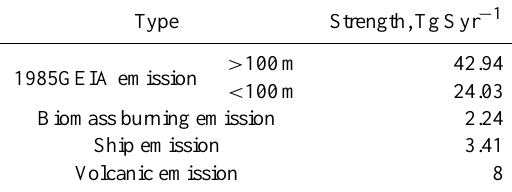
Table 2. SO 2 global emissions used in